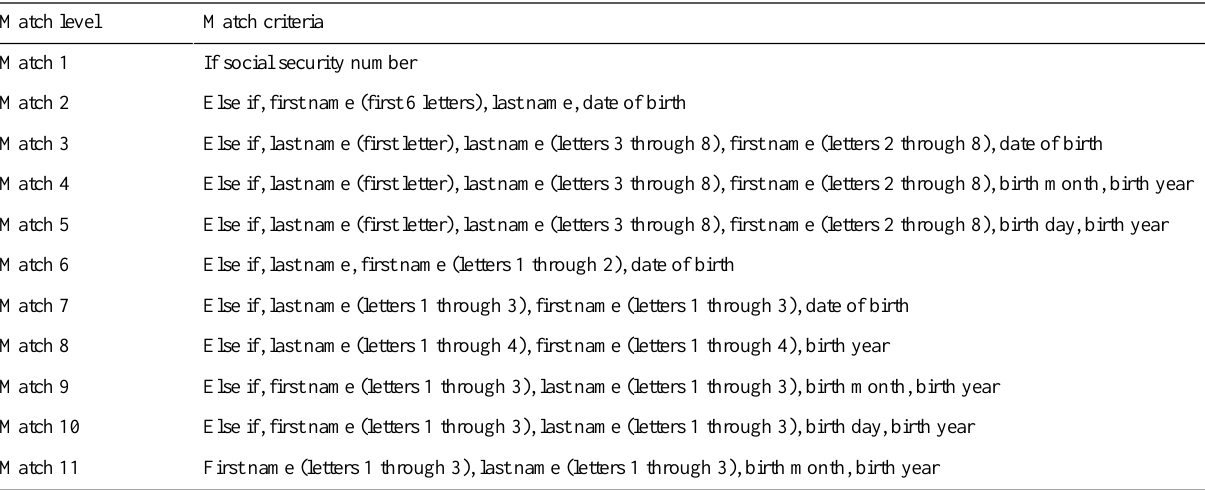
Table 1. Surveillance data matching algorithm.